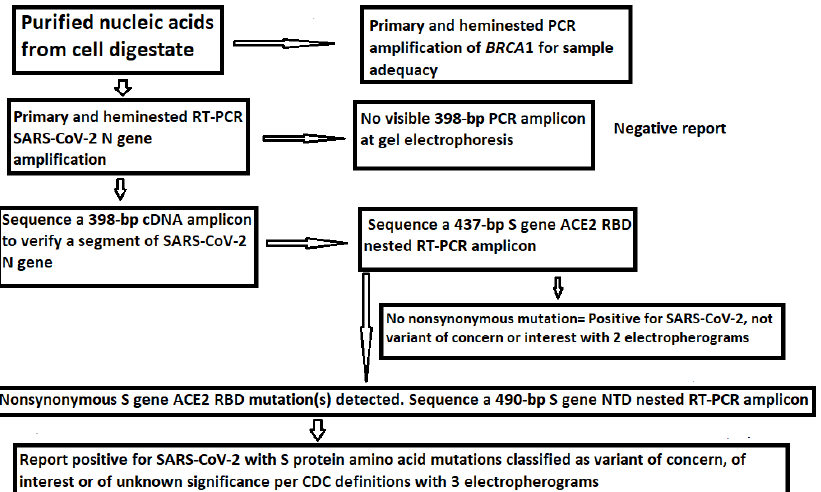
Figure 3. Workflow diagram for SARS-CoV-2 VOC and VOI determination by Sanger sequencing.